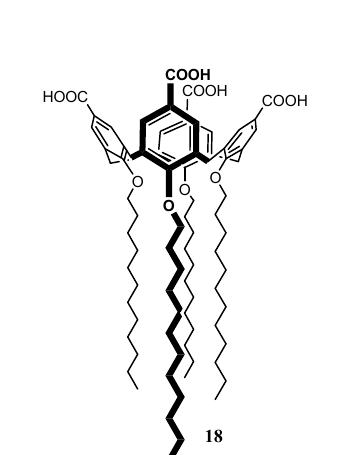
COOH HOOC COOHCOOH O O O O